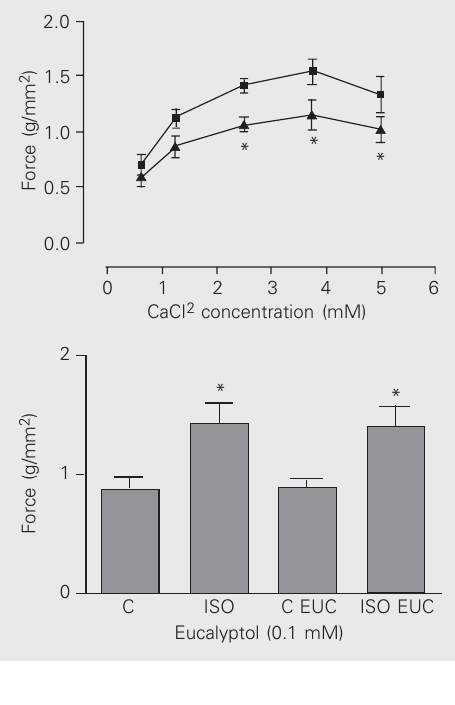
Figure 5. Effect of increasing concentrations of eucalyptol on the tetanic force development measured at peak (upper panel) and half decay time (lower panel). Data are reported as means ± SEM for N = 10. *P < 0.01 for eucalyptol vs control (C, one-way